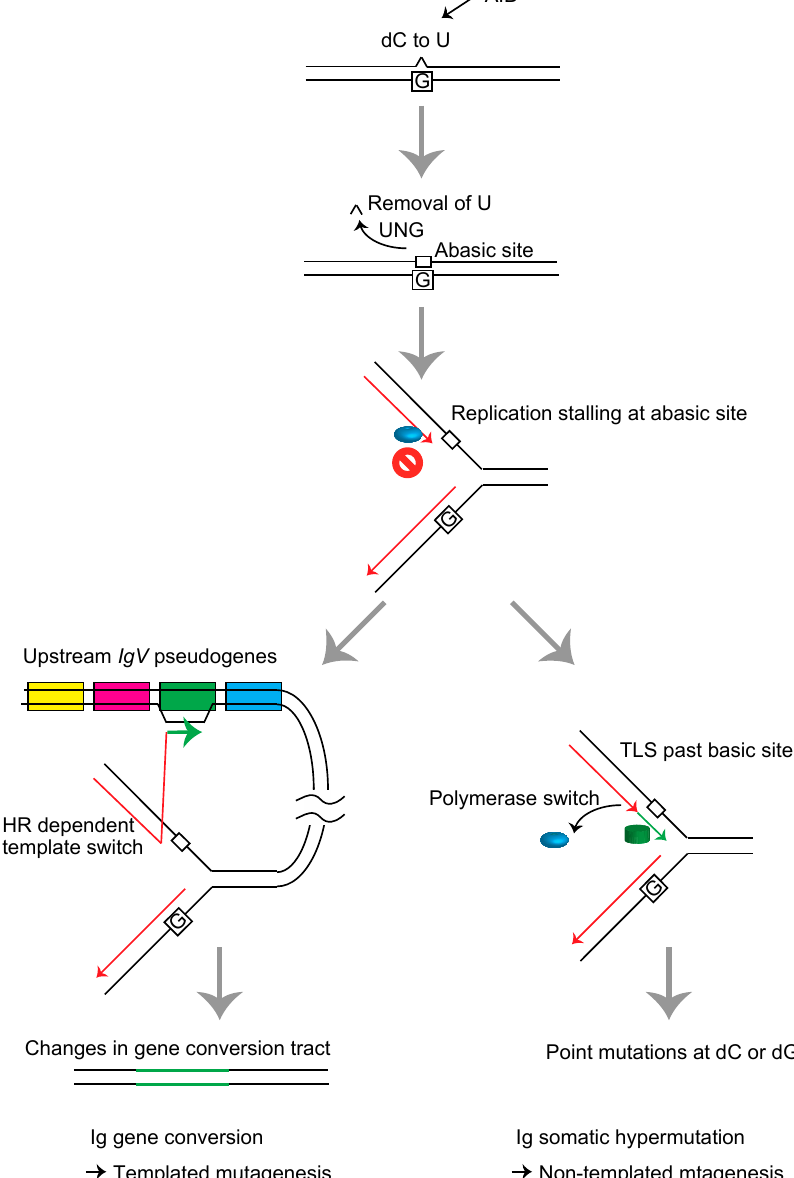
Figure 2. Schematic representation of the immunoglobulin variable ( IgV) gene diversification mechanism in DT40 cells. The sequential actions of activation-induced deaminase (AID) and uracil DNA glycosylase (UNG) induce abasic sites in the IgV gene. The replication fork arrests at these lesions and induces template switch-mediated gene conversion with one of the 25 copies of upstream IgV pseudogenes carrying a ~10% mismatch rate, resulting in HR-mediated diversification/mutagenesis of the immunoglobulin gene (left), or TLS, resulting in somatic hypermutation at the dC/dG base pairs (right). When the blocking lesions are abasic sites, DDT processes serve additional functions,